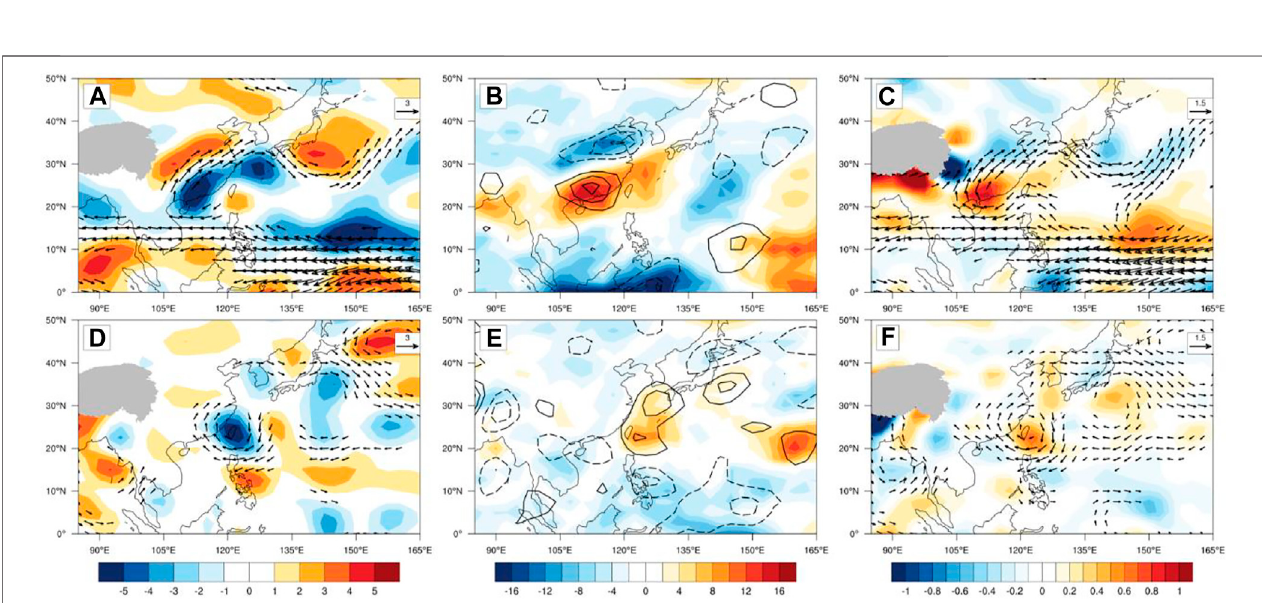
FIGURE 4 | Left column: differences in 850 hPa wind (vectors, unit : ms − 1 ) and relative vorticity (shaded, unit : 10 − 6 s − 1 ) between their composites of positive and negative years. Middle column: differences in outgoing longwave radiation (OLR, shaded, unit : W m − 2 ) and omega vertically integrated from 850 to 500 hPa (contours, contour interval: 2, unit : kg ( m · s ) − 3 ) between the composites of positive and negative years. Right column: differences in water vapor fl ux (vectors, unit : kgm − 1 s − 1 ) verticallyintegratedfrom1,000to500 hPaanditsdivergence(shaded, unit : 10 − 6 kgm − 2 s − 1 )betweenthecompositesofpositiveandnegativeyears.[ (A – C) forP1; (D – F) for P2; only values signi fi cant at/above the 95% con fi dence level by Student ’ s ttest are shown. The dashed lines indicate values greater than zero while solid lines indicate values less than zero in (B,E) ].